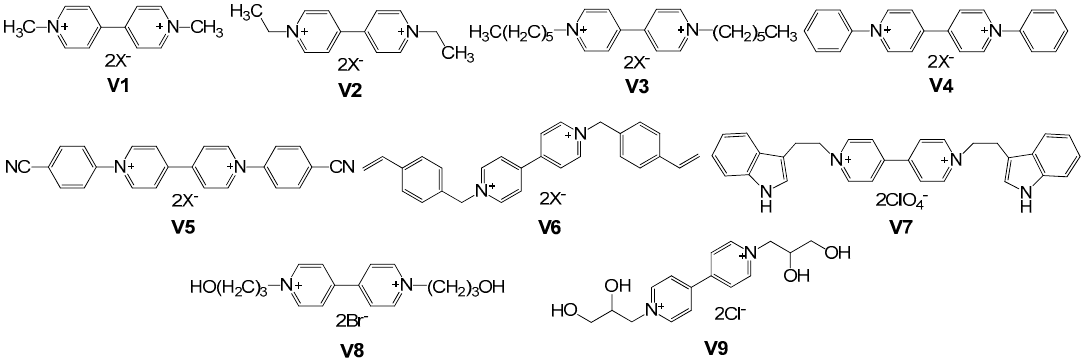
Figure 3. Structures of small molecular viologens with various substituents at nitrogen positions.